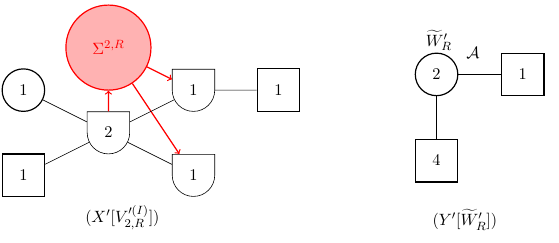
Figure 43 . A 3d-1d system which realizes a vortex defect in the flavored D 4 quiver, and the dual Wilson defect in the U(2) gauge